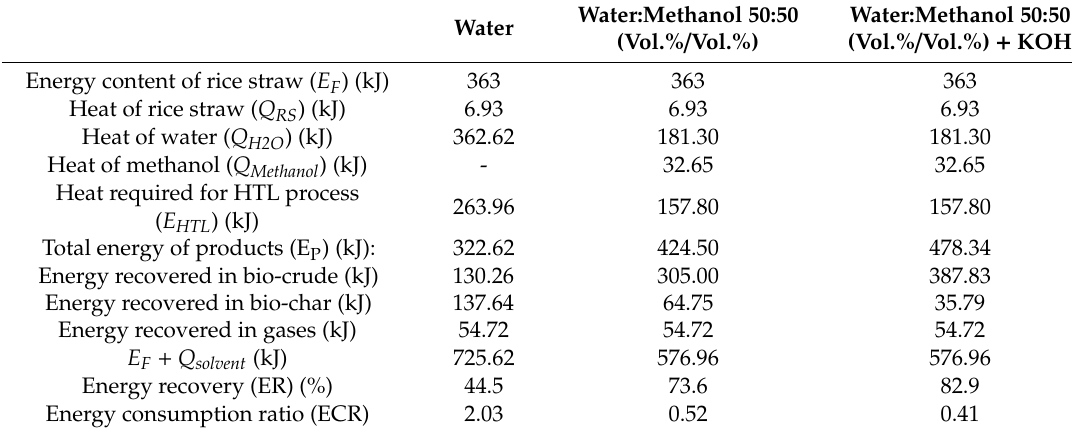
Table 6. Energy calculations to determine energy recovery and ECR in HTL of rice straw at 300 ◦ C, 60 min, and rice straw:solvent ratio of 1:10 wt. /